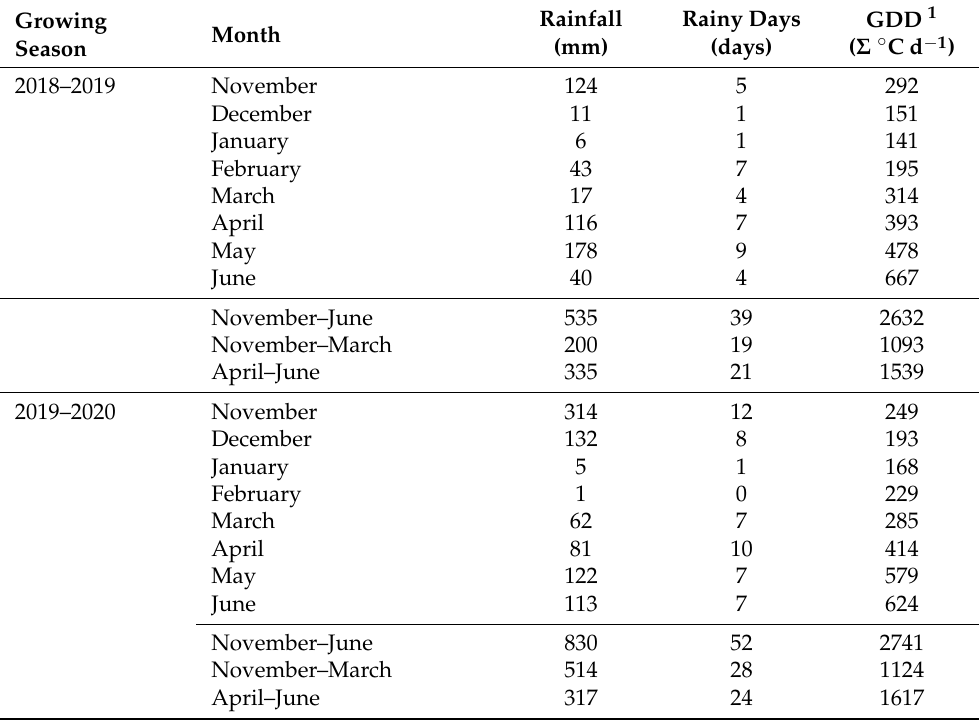
Table 1. Monthly rainfall, rainy days, and growing degree days (GDD) from the sowing (November) to the end of ripening stage (June) in the two growing